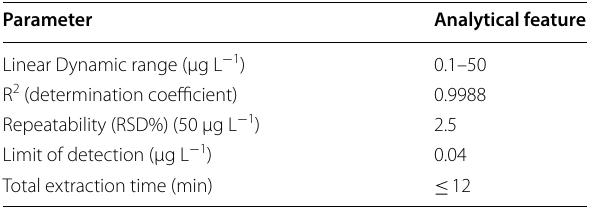
Table 1 Analytical figures of merit for Zr-MOF-NH2 for extraction of CBZ Parameter